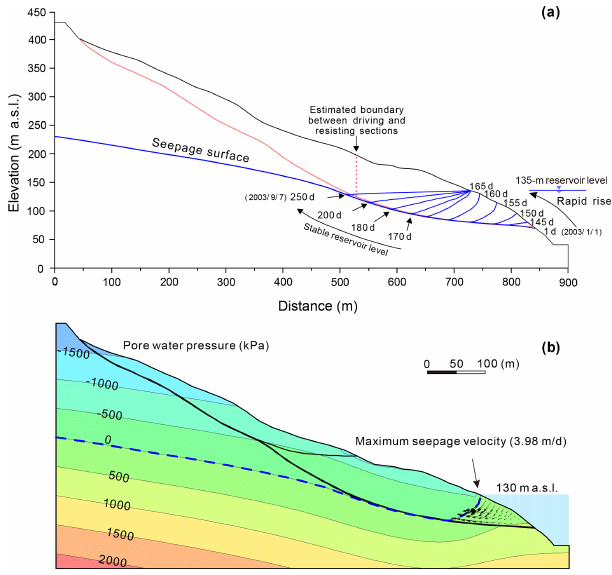
Figure 14. (a) Simulated groundwater tables during the period of rapid reservoir rise from 1 January 2003 to 7 September 2003, (b) simulated pressure contours and flow vector on 19 June 2003 ( a + 170d) during first impoundment period.